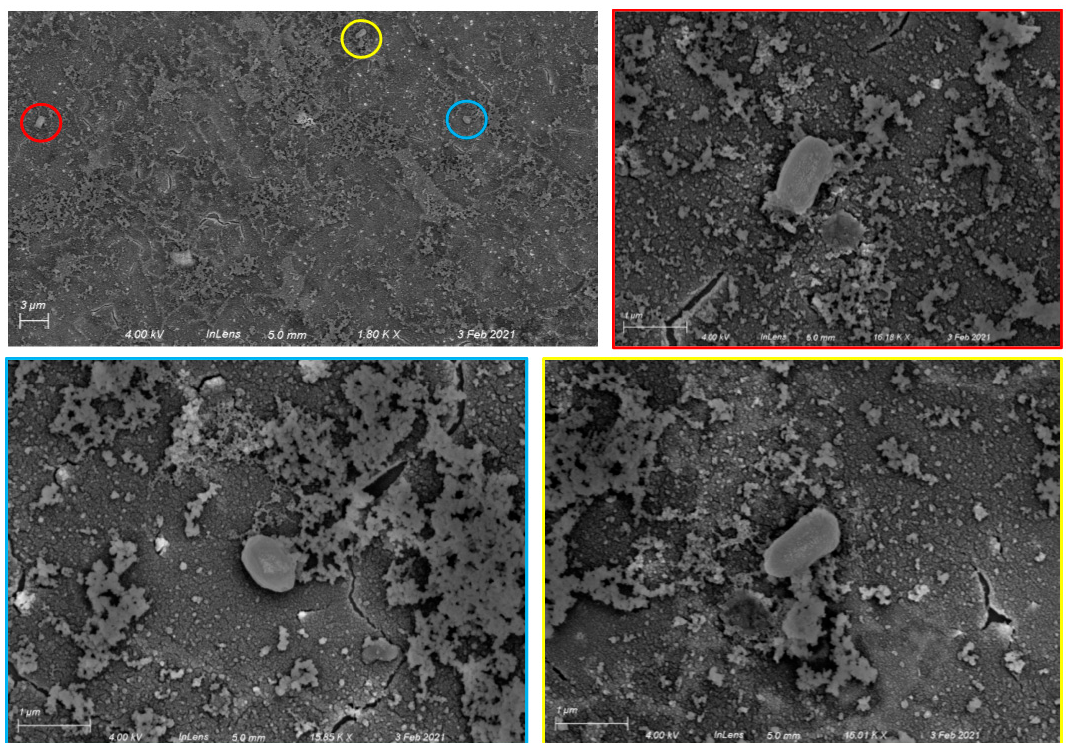
Figure 3. Specific capture of Bacillus subtilis spores on Al/Al 2 O 3 surfaces with covalently attached anti- B. subtilis antibodies. Top left : 1800× image showing three spores (circled). Top right and bottom : higher magnification images (15,850×–16,180×) showing individual spores. The color framing each high-magnification image corresponds to the circled area in the lower-magnification image.